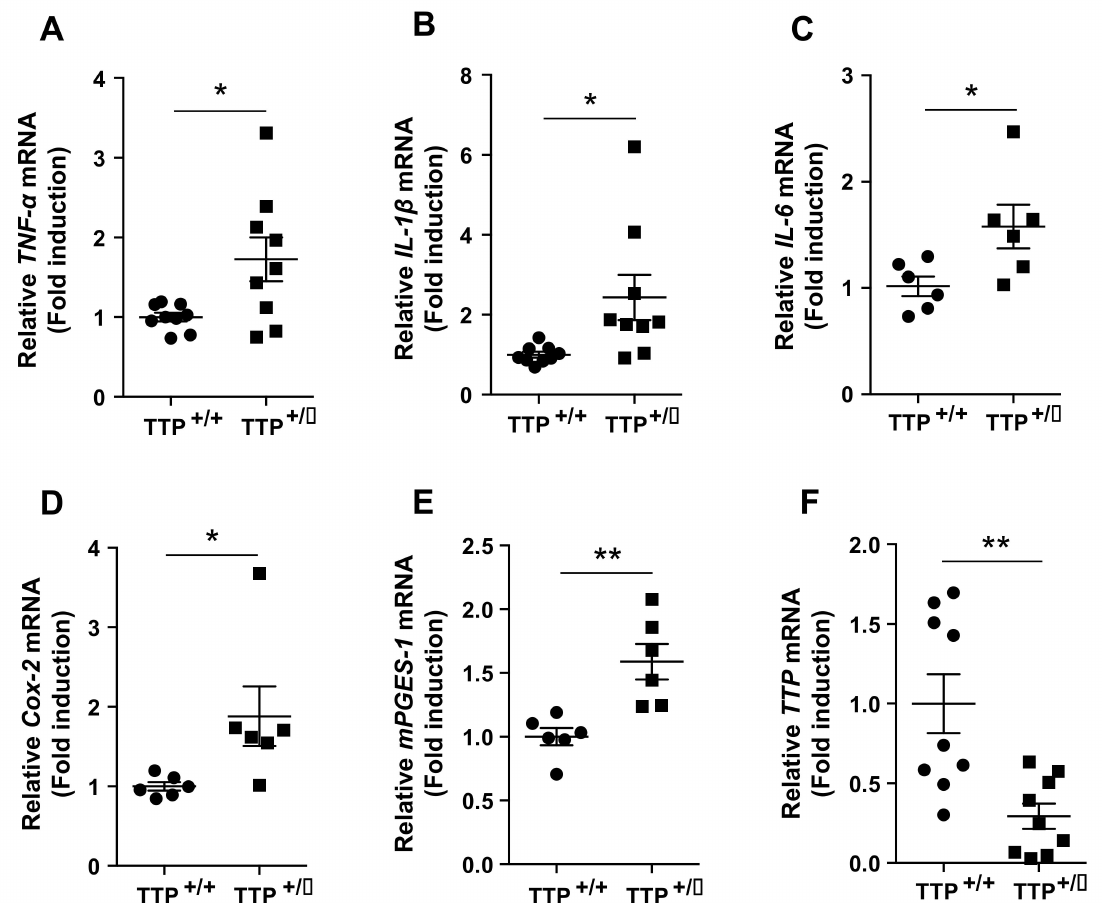
Figure 2. Upregulation of pro-inflammatory genes in the hypothalamus of TTP-deficient mice. Elevated mRNA levels of pro-inflammatory cytokines including ( A ) TNF- α , ( B ) IL-1 β , ( C ) IL-6 , and genes involved in the synthesis of prostaglandin E 2 , including ( D ) Cox-2 and ( E ) mPGES-1 in the hypothalamus of the TTP-deficient (TTP +/ − ) mice compared to that of wild type (WT) mice (TTP +/+). ( F ) qPCR data reveal a significant reduction in TTP mRNA in the hypothalamus of the TTP-deficient mice compared with that in WT mice. Data are presented as the mean ± SEM. n = 9 mice per group for Figure 2A,B,F; n = 6 mice per group for Figure 2C–E. * p < 0.05 and ** p < 0.01. SEM; standard error of the